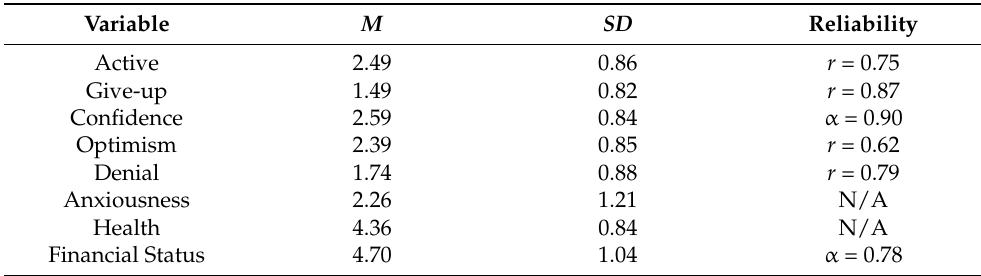
Table 1. Descriptive Statistics ( N = 3834; 55% Women, 50% aged 30 and over).